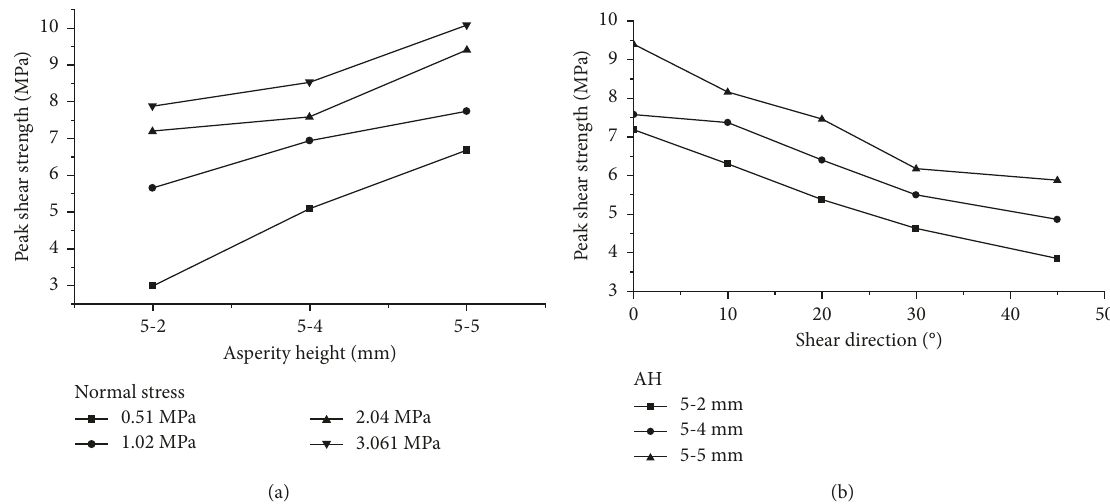
Figure 18: Relationship between shear directions as well as asperity heights and peak shear strengths. (a) Different asperity heights (NS 2.04MPa); (b) different normal stresses (SD (cid:31)